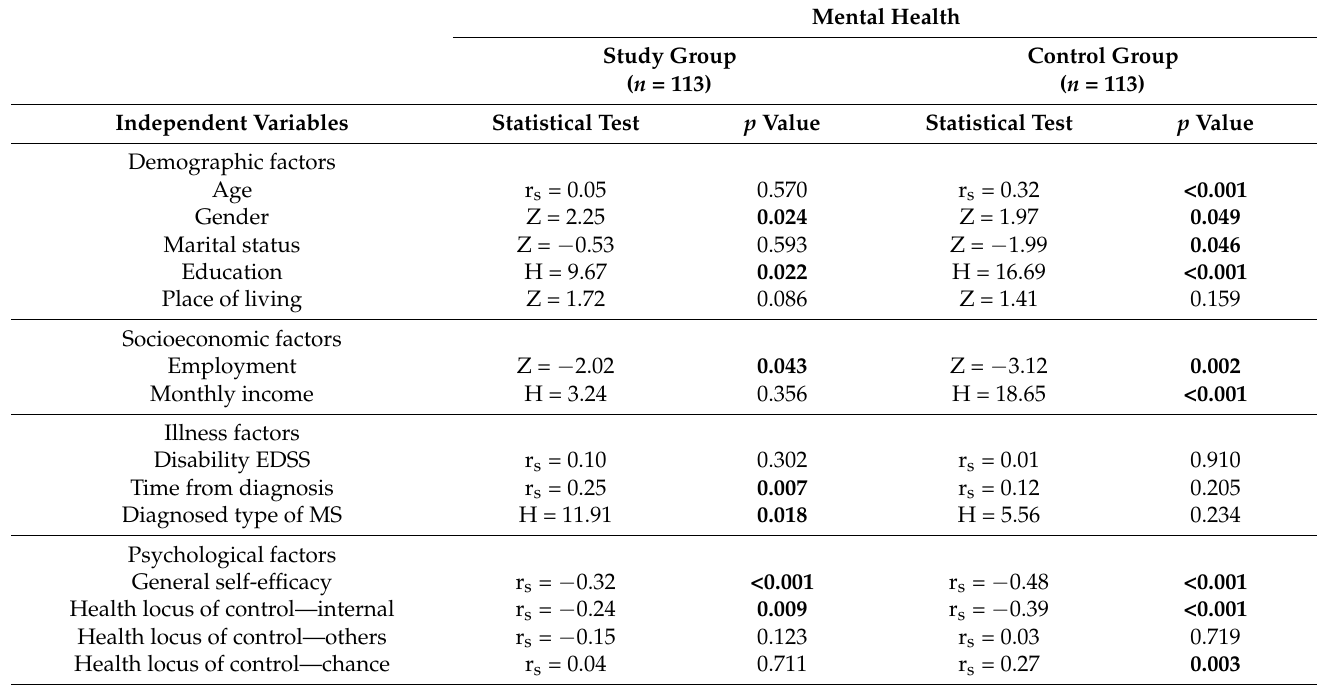
Table 3. Associations between selected independent variables and mental health in persons with MS studied in 2020 and control group studied in 2017.